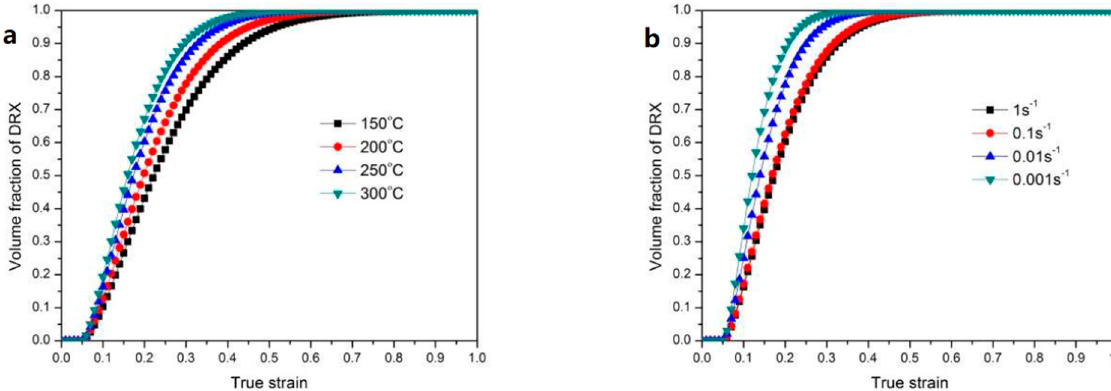
Figure 6. Predicted results of the relation between recrystallized volume fraction and true strain: ( a ) Strain rate = 1 s − 1 with various temperatures; ( b ) T = 250 °C with different strain rates.